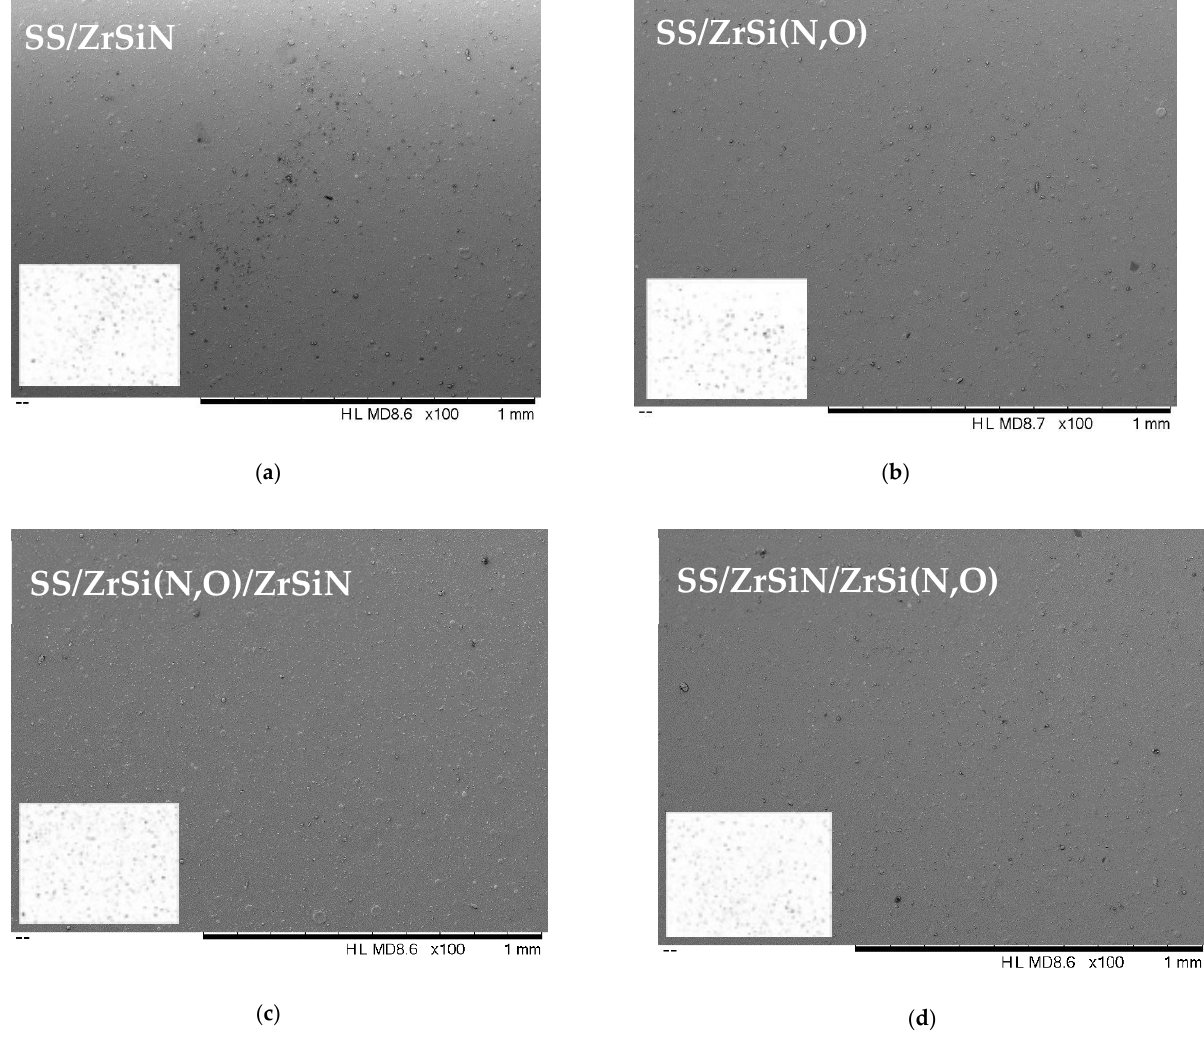
Figure 1. SEM micrographs (HL MD8.6 × 100, 1 mm) and the corresponding binary images (produced by ImageJ ® software) of the investigated coatings: SS/ZrSiN ( a ), SS/ZrSi(N,O) ( b ), SS/ZrSi(N,O)/ZrSiN ( c ), and SS/ZrSiN/ZrSi(N,O) ( d ).